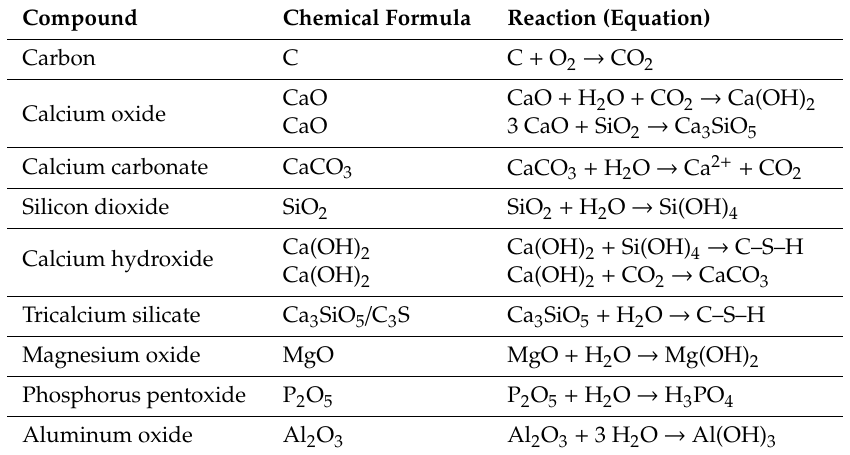
Table 5. Potential compounds and their reactions occurred during the hydration of BioAsh.